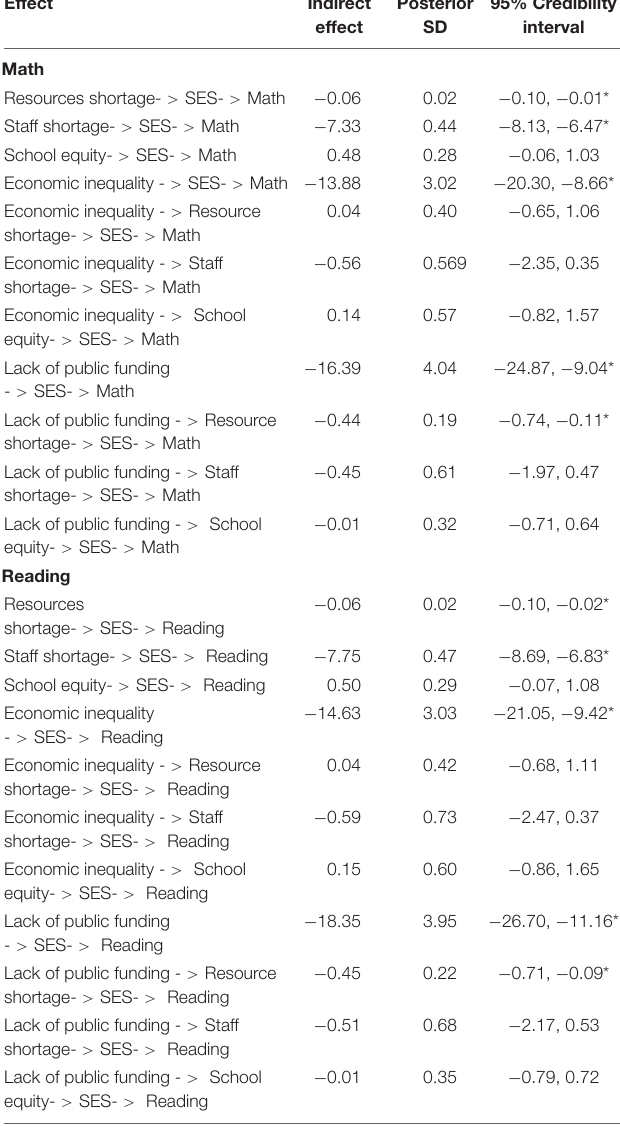
TABLE 6 | Indirect effects: Math and